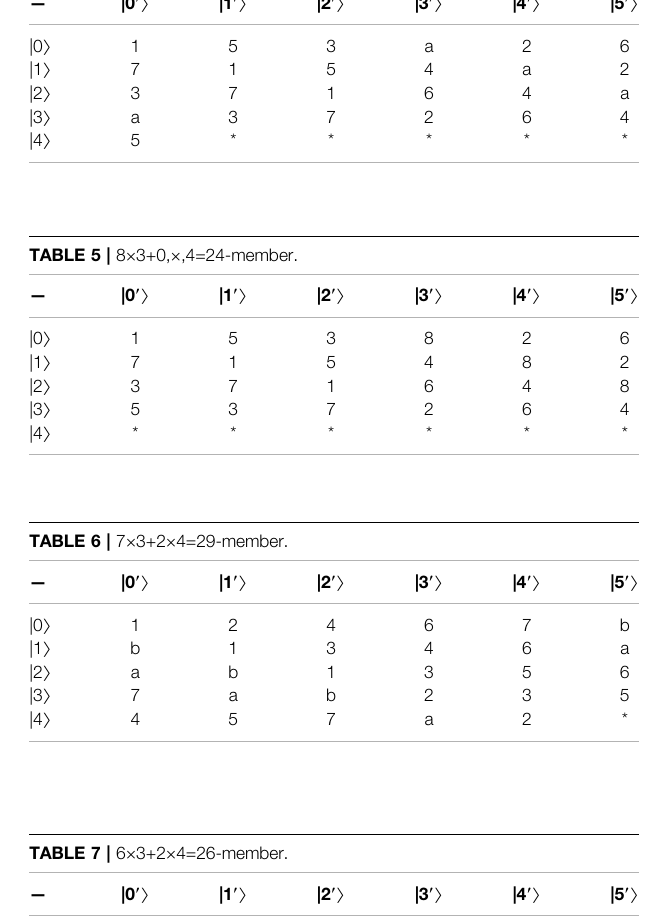
TABLE 4 | 7×3+1×4=25-member.